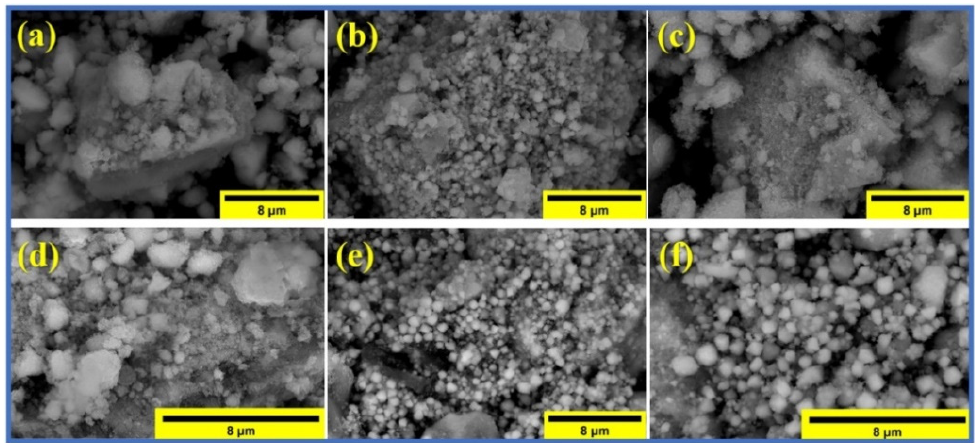
Figure 2. SEM images: Co-ferrite ( a ), Mn-ferrite ( b ), Co-Mn ferrite ( c ), Co-ferrite/graphene composite ( d ), Mn-ferrite/graphene composite ( e ), and Co-Mn ferrite/graphene composite ( f ). The graphene in the composite samples appeared in the images (d), (e), and (f). For more composition confirmation, the EDX was used. The EDX patterns and tables are shown in Figure 3a–f, confirming the proper chemical compositions of the three pre- pared ferrite samples and the three composite samples with their intended elemental